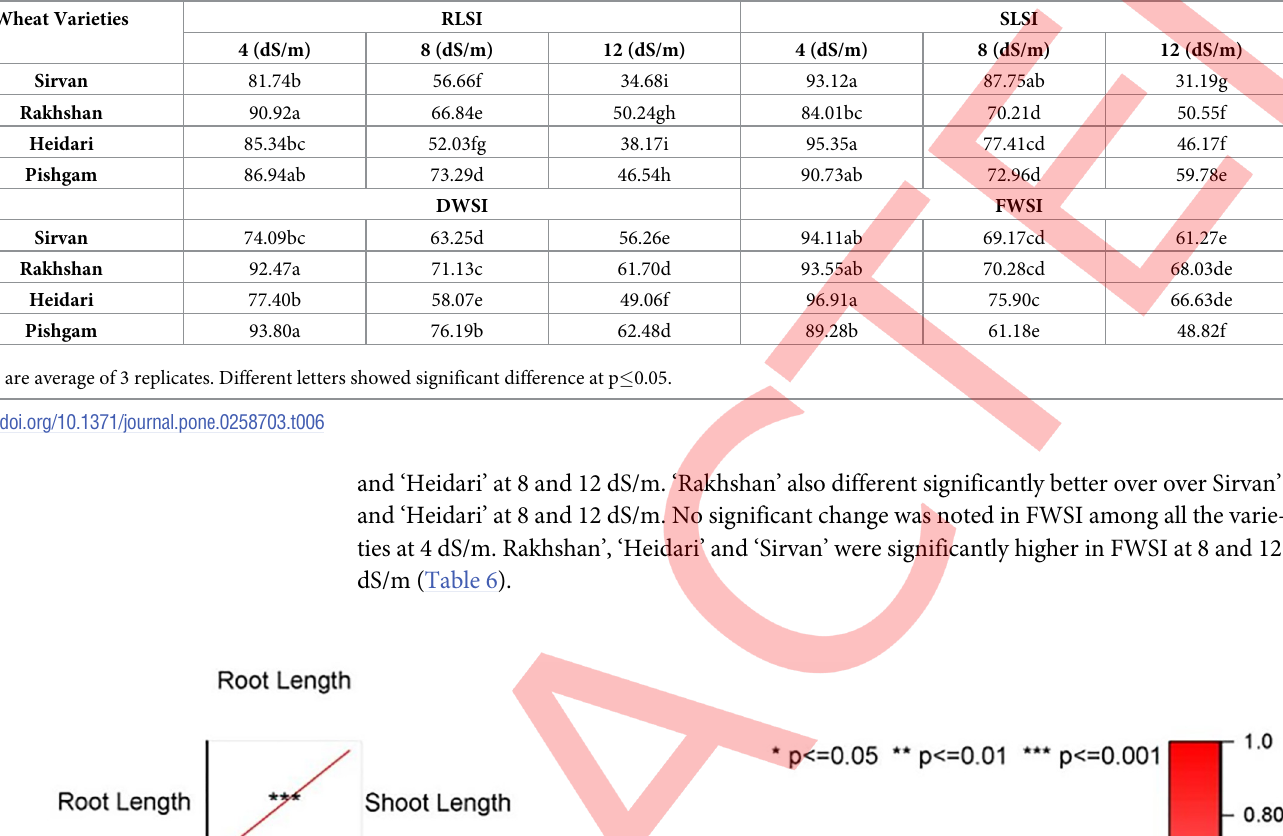
Table 6. Stress tolerance index of different wheat varieties under variable salinity levels. Wheat Varieties